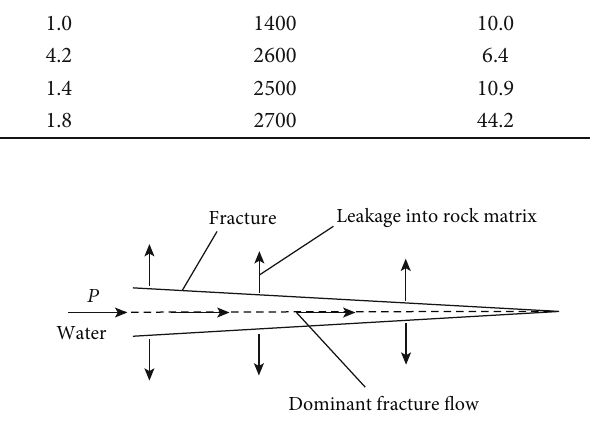
Figure 3: Water paths of dominant fracture fl ow and minor leakage into rock matrix. P is water pressure.